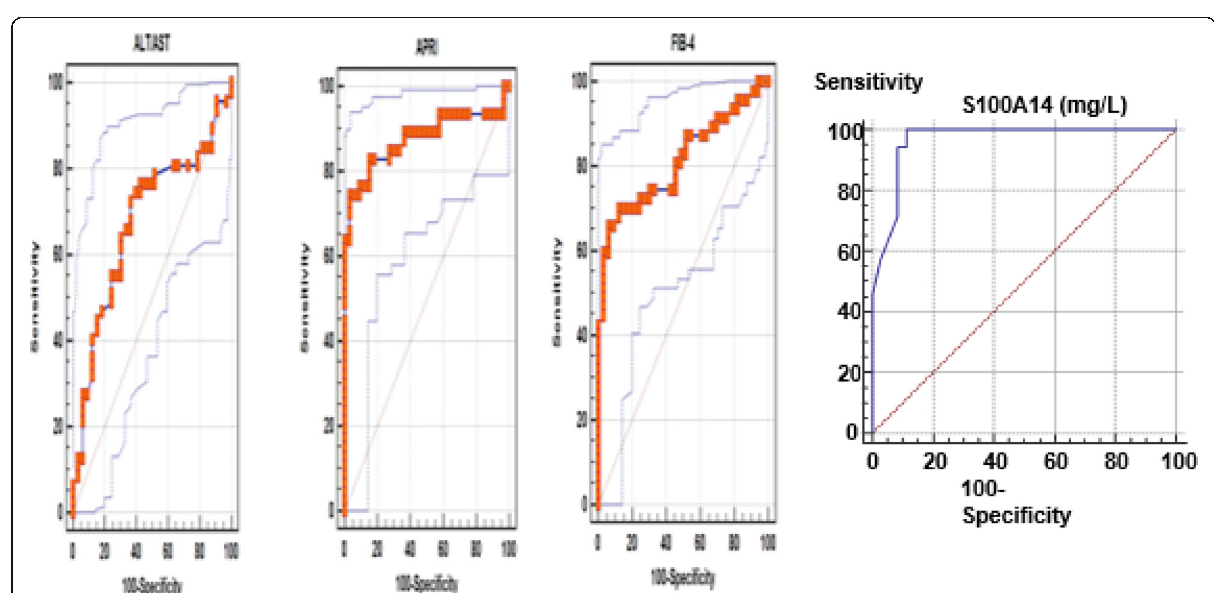
Fig. 2 Receiver operating characteristics analysis for AAR, APRI, FIB-4, and S100A14